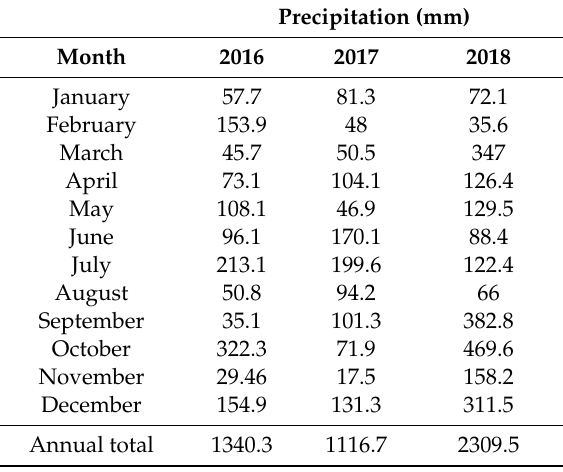
Table 4. Monthly and annual precipitation totals for study